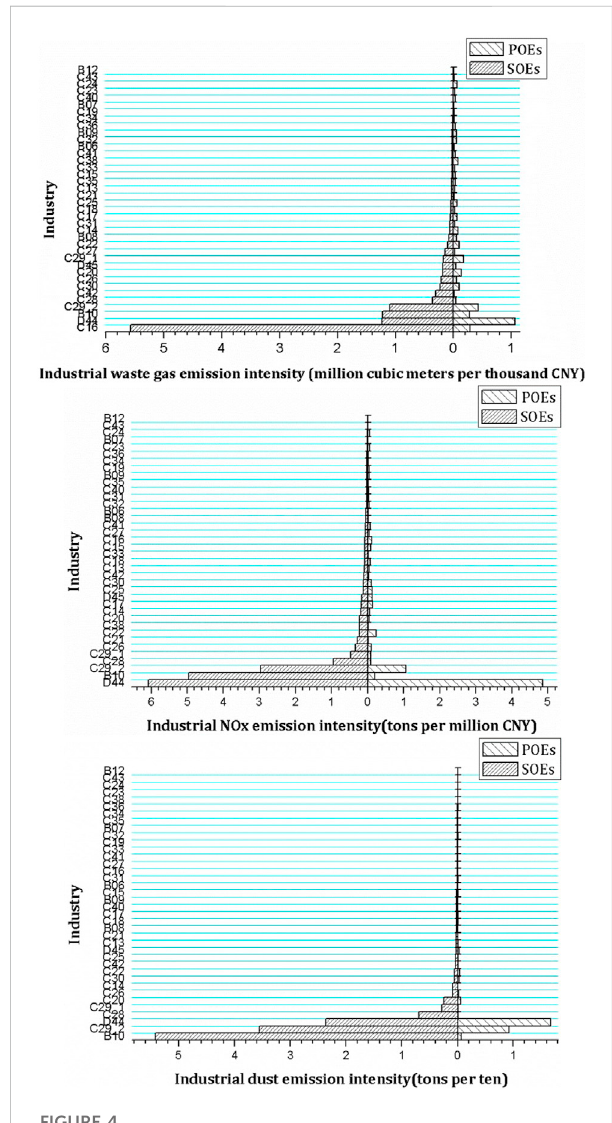
FIGURE 4 Pollutant emission intensities of 39 industrial sectors in